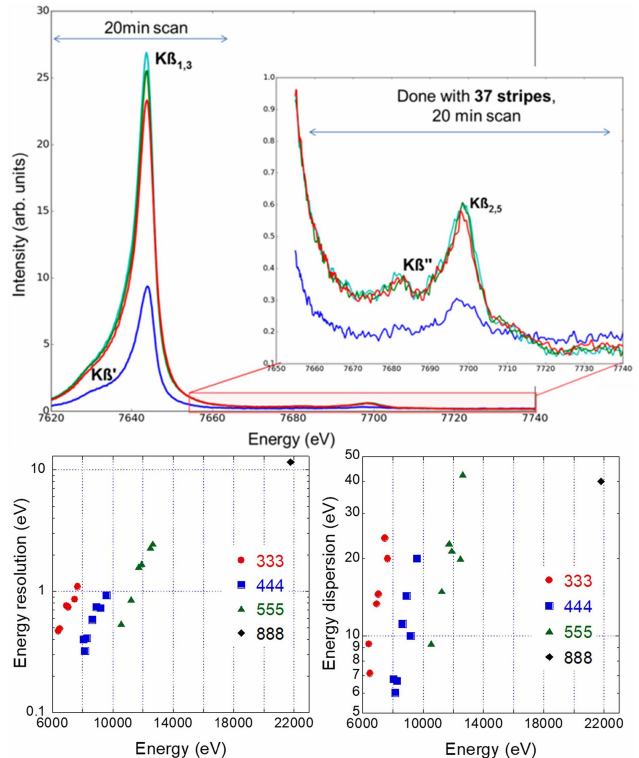
Figure 3 (Top) Representative Co K (cid:2) emission spectra collected in 20 min for bulk samples (Li x CoO 2 crystals, with different x content: 0.99, 0.66 and 0.46; the blue line corresponds to the signal collected for a pellet sample, while the others to signals obtained by measuring single crystals). (Bottom) Energy resolution and dispersion for several emission lines reachable with the Si 333, Si 444, Si 555 and Si 888 reflections empirically